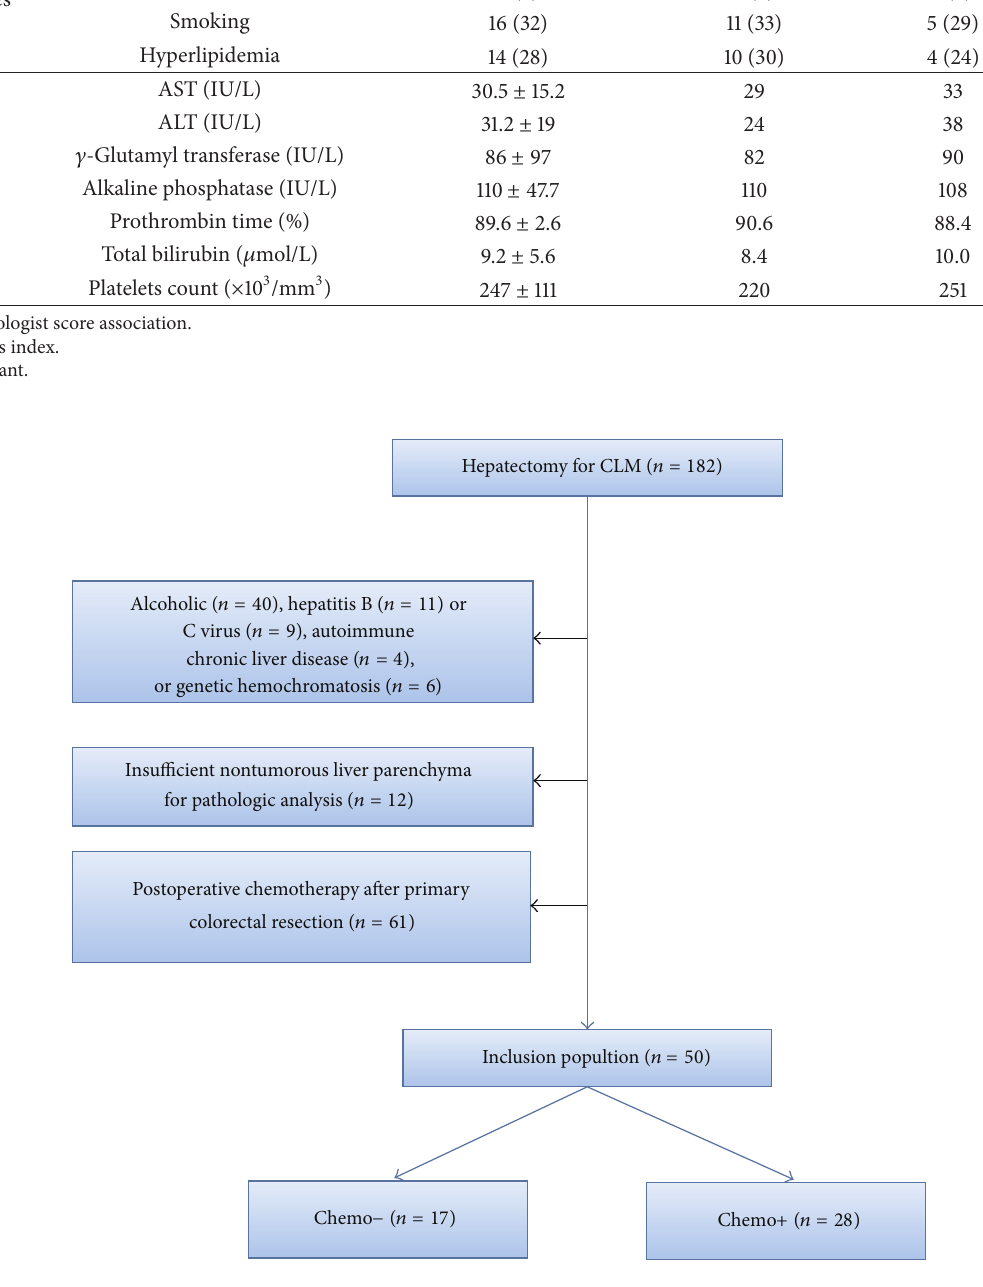
Figure 1: Flow chart of the